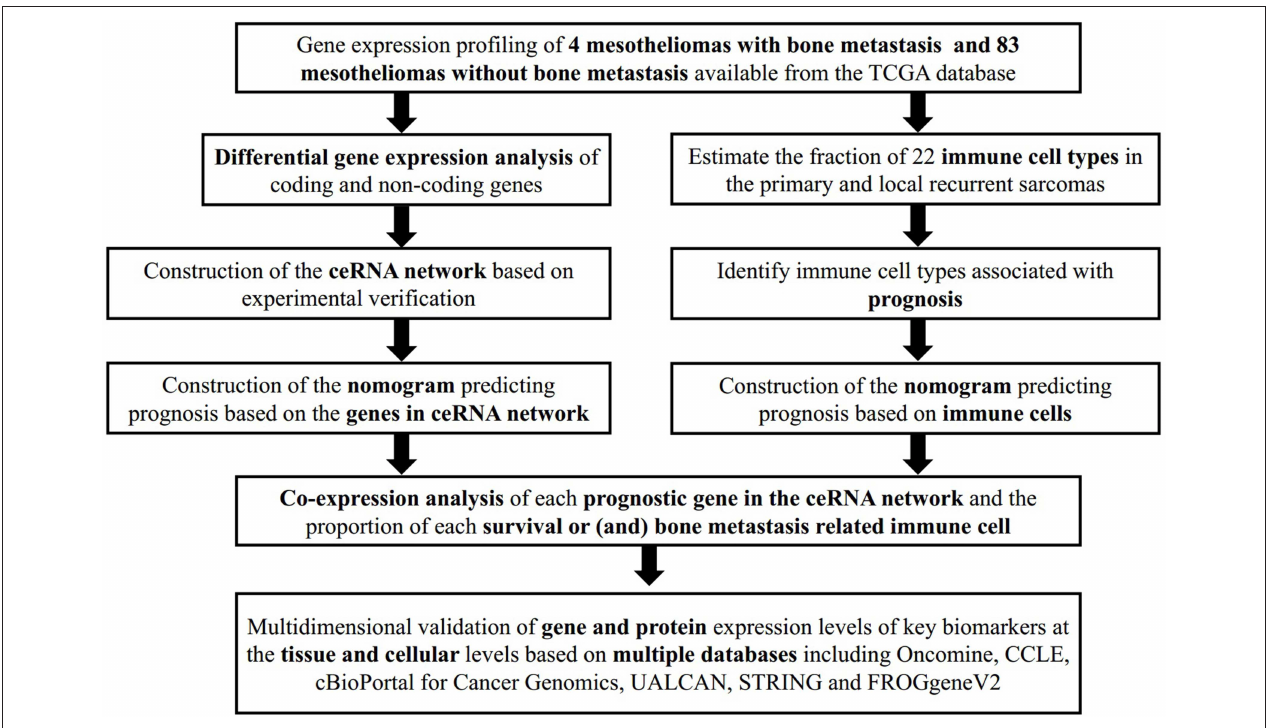
FIGURE 1 | The flow chart of the analytical